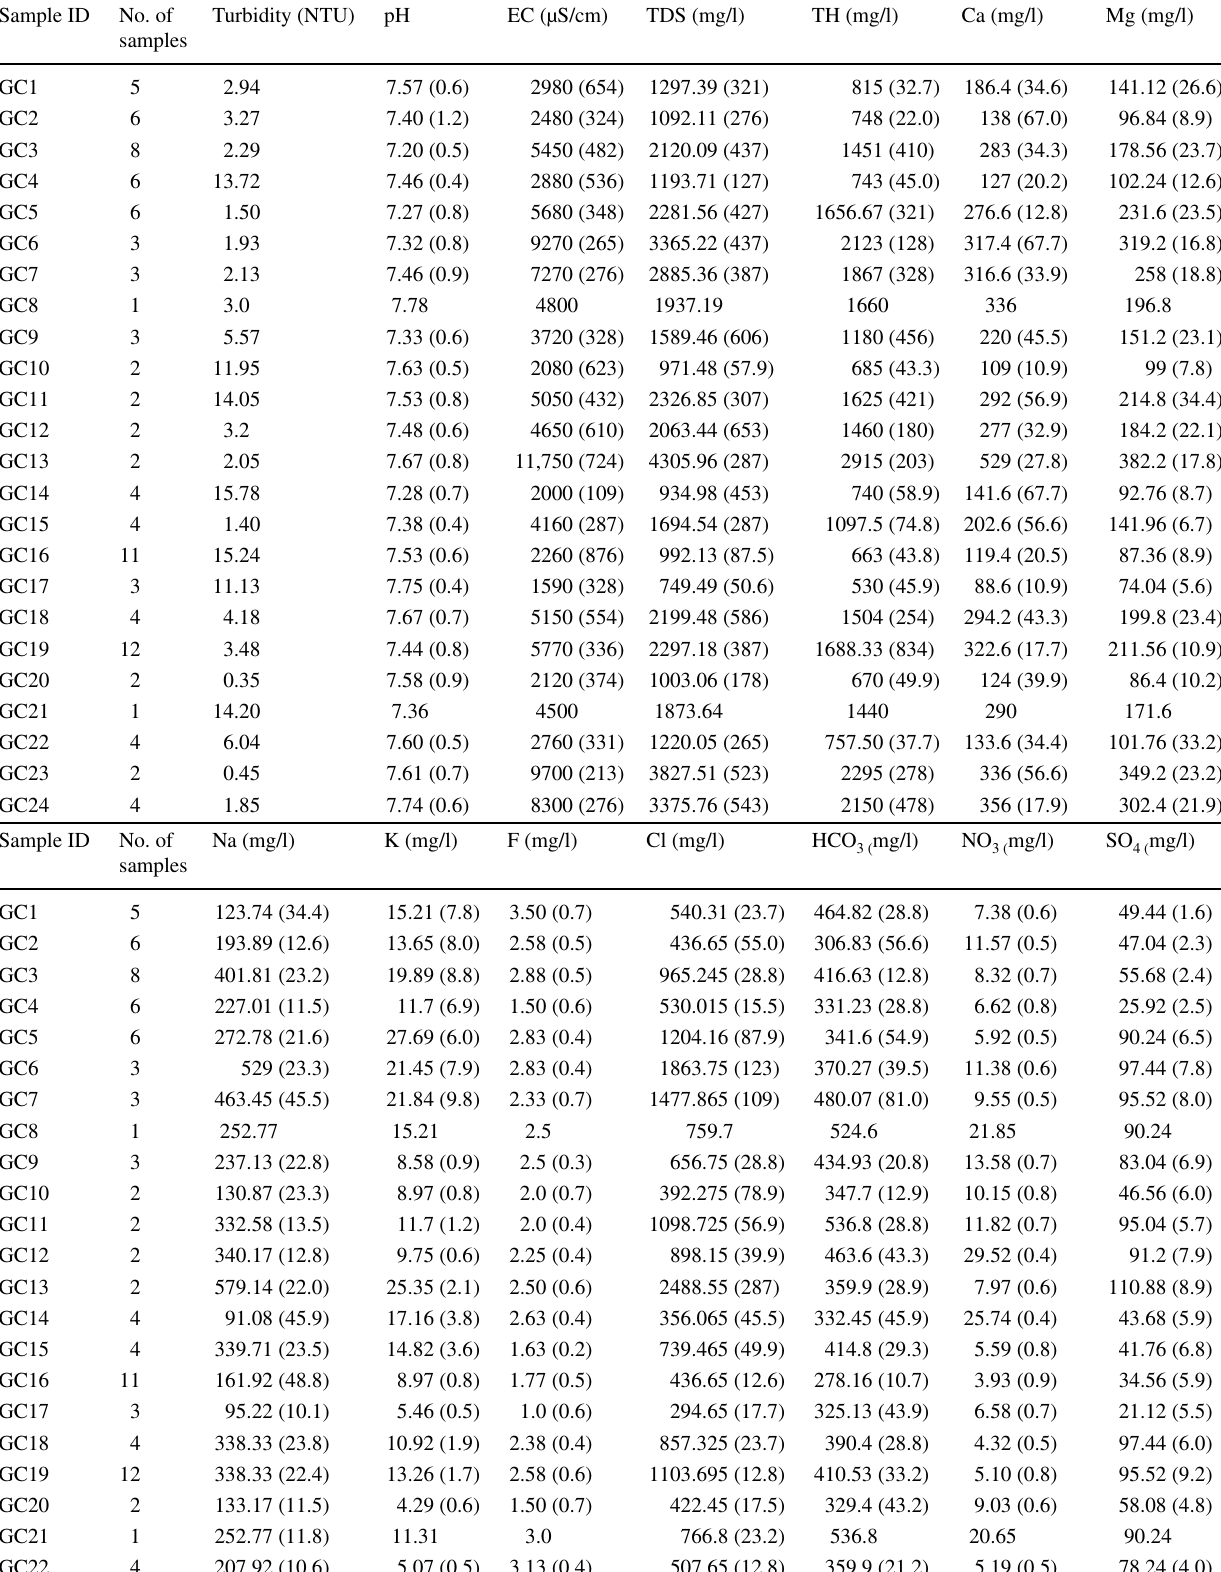
Table 3 Analytical results (mean values) of groundwater samples in Gang Canal catchment area (site 3) Sample